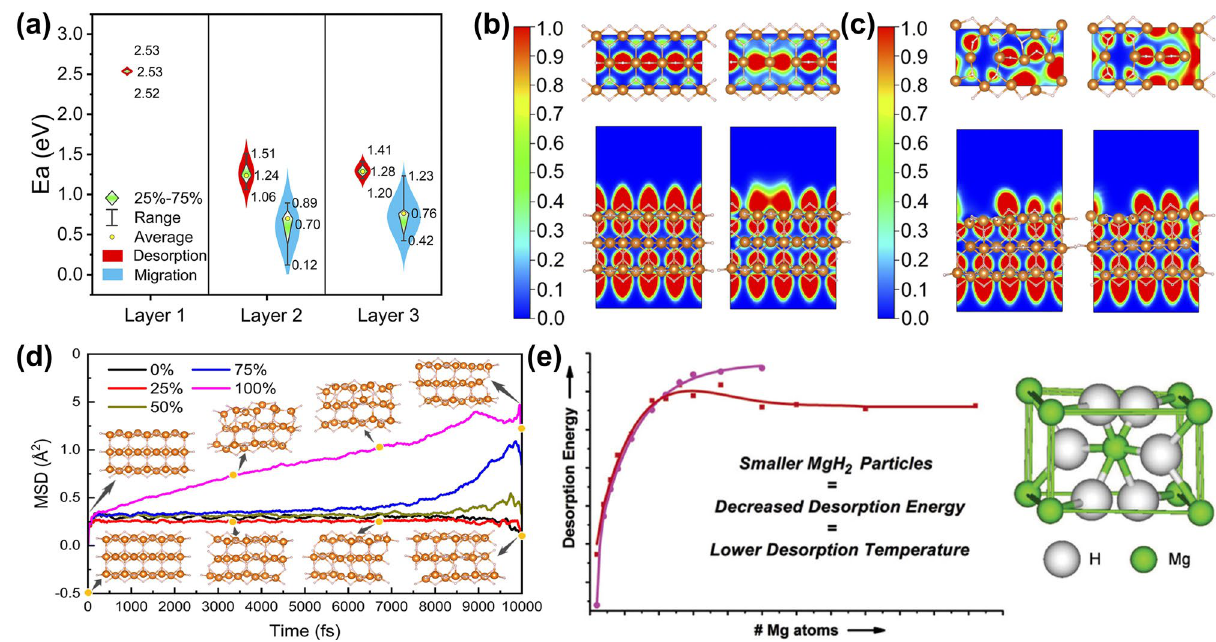
Fig. 3 a Comparison of the three-layer atomic H migration and dehydrogenation energy barriers. The calculated ELFs of MgH 2 before the dehydrogenation b in processes 1 and 2 (the first layer) and c in processes 3 and 4 (the second layer). d AIMD simulations on MgH 2 (110) before and after surface H loss. Yellow dots are the selected points of MgH 2 before (0%) and after (100%) surface H loss at 500 K. White and orange spheres represent H and Mg, respectively. Reproduced with permission from Ref. [19]. Copyright 2022 Royal Society of Chemistry. e Calculated desorption energies for MgH 2 clusters with both the HF method and DFT method. Reproduced with permission from Ref. [68]. Copyright 2005 American Chemical Society. (Colour figure